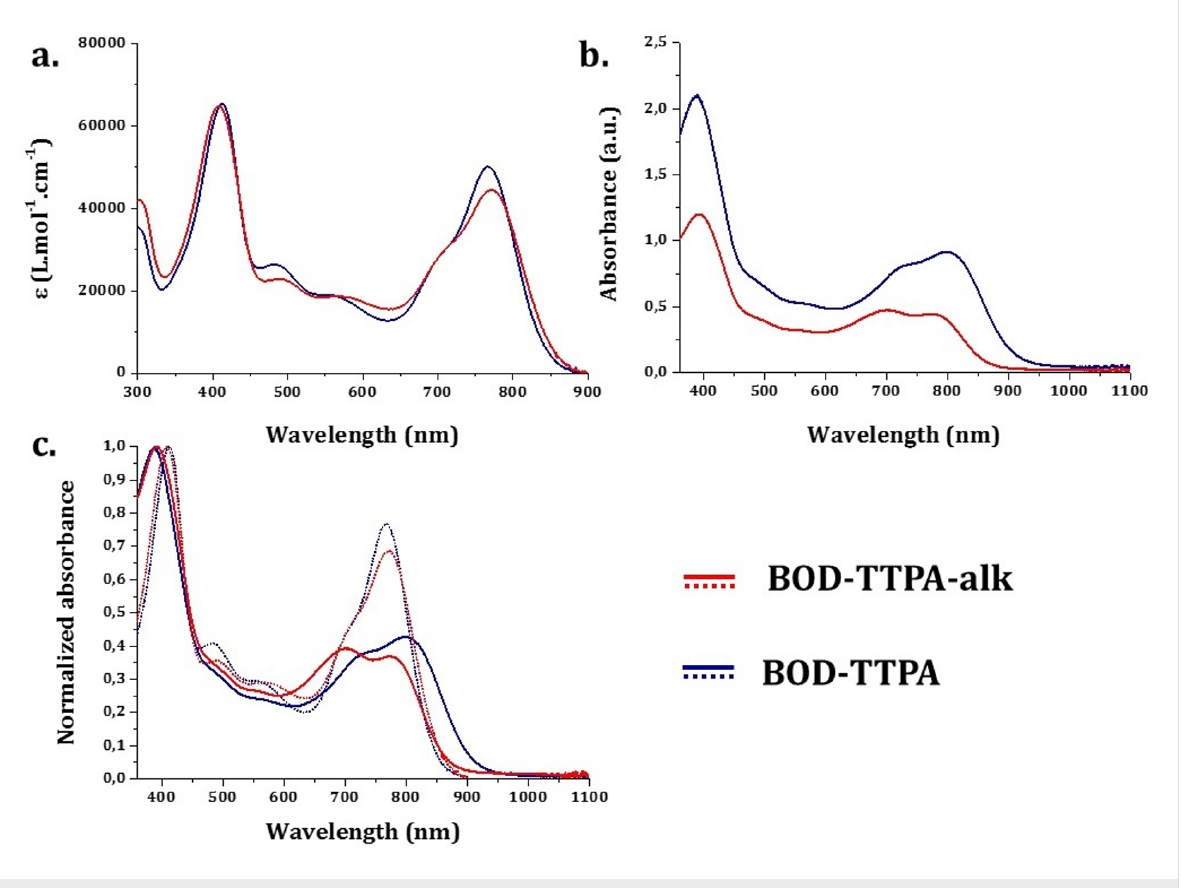
Figure 5: a) Absorption spectra of compounds BOD-TTPA-alk and BOD-TTPA (THF, ≈ 10 − 6 M, 25 °C). b) Absorbance spectra of 2 µm thick meso- porous TiO 2 sensitized in a solution of dye/CDCA (1:10, molar ratio). c) Normalized absorbance spectra of BOD-TTPA-alk (red traces) and BOD- TTPA (blue traces), both in diluted solution (aerated THF, ≈ 10 − 6 M, 25 °C – dashed lines) and once adsorbed on 2 µm thick mesoporous TiO 2 (solid